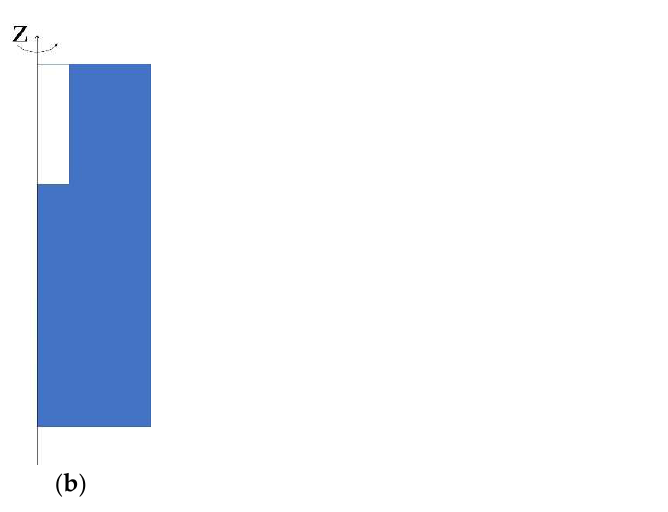
Figure 2. The single Helmholtz resonator. ( a ) Schematic diagram of the cylindrical representative hexagonal structure; ( b ) Schematic diagram of the 2D rotationally symmetric model for the finite element analysis. Table 1. The initial geometric parameters of the proposed acoustic metamaterial.